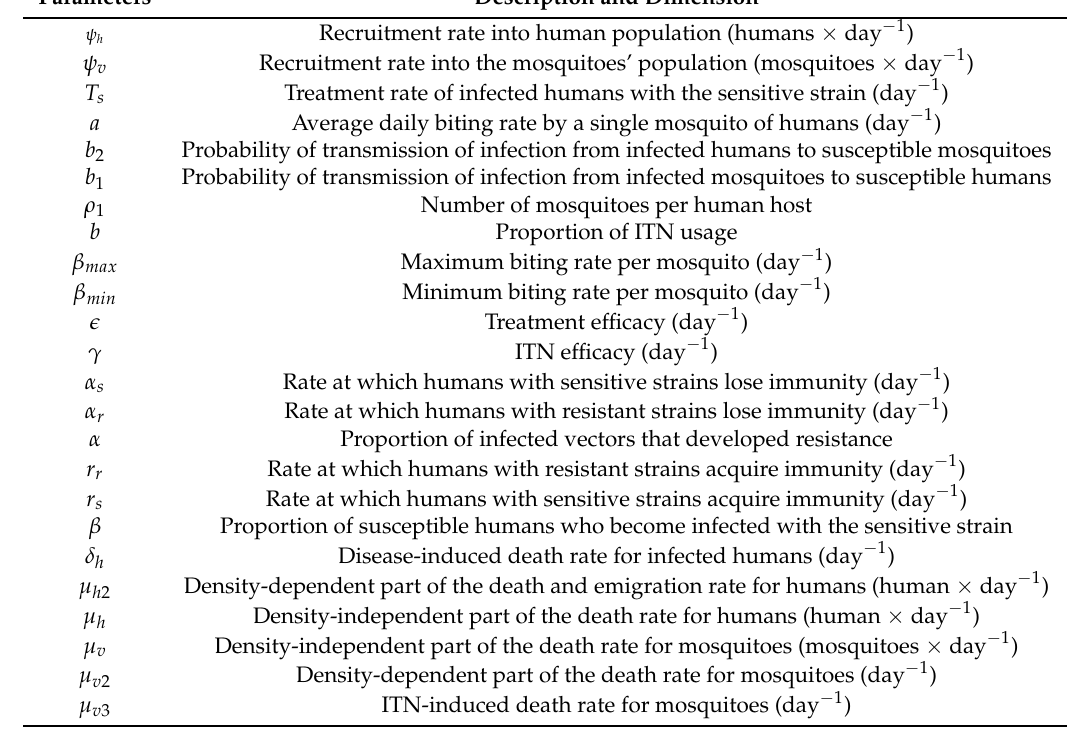
Table 2. Parameters and their descriptions. ITN, insecticide-treated bed-net.